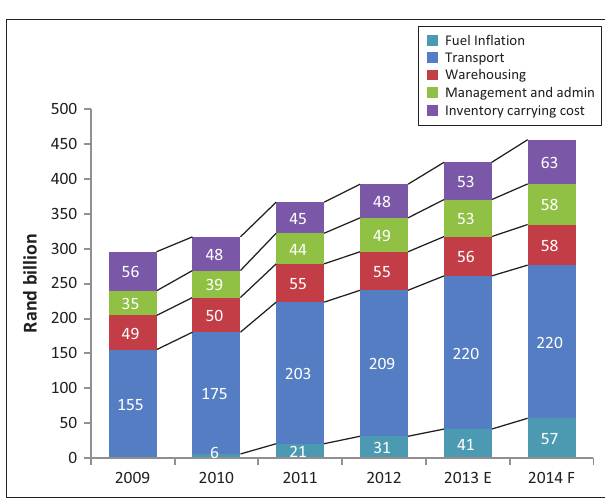
E, estimated; F, forecast. FIGURE 6: The impact of fuel inflation on logistics costs since